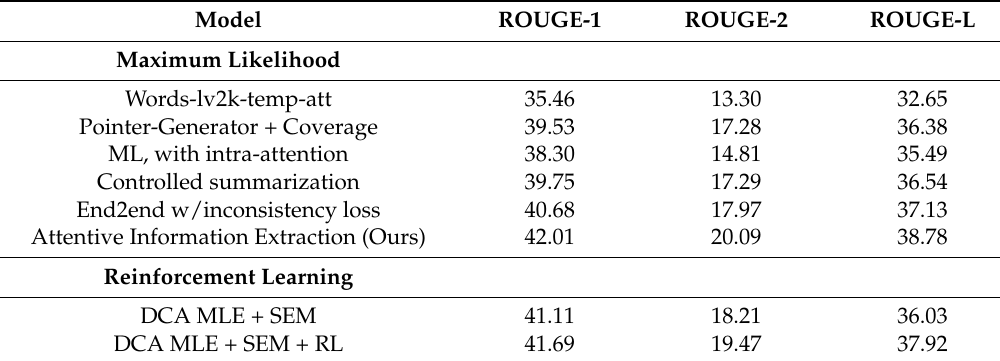
Table 4. ROUGE F1 on CNN/Daily Mail. All our ROUGE scores have a 95% confidence interval in the official ROUGE script.